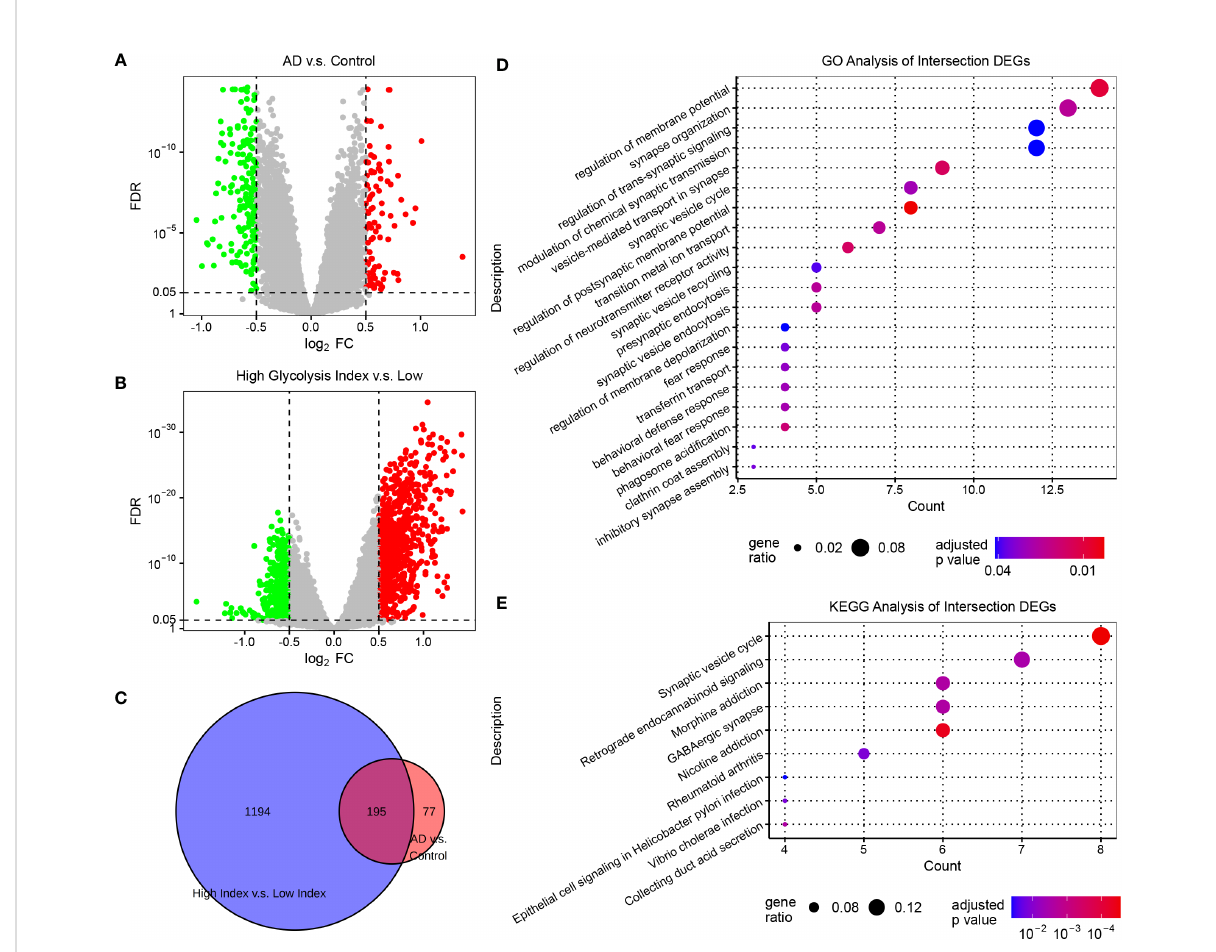
FIGURE 2 Screening glycolysis-related genes, and their relevant signaling pathways and functions in AD (A) Volcano plots of DEGs in AD vs. control samples. (B) Volcano plots of DEGs between AD samples with low and high glycolysis indices. The genes with FDR <0.05 and |log 2 FC|>0.5 are considered signi fi cant. (C) Venn diagram of the overlapping genes between the two differential expression analyses. (D) The GO enrichment analysis of intersection DEGs. (E) The KEGG enrichment analysis of intersection DEGs. DEG, differentially expressed genes; AD, Alzheimer ’ s disease; FDR, false discovery rate; GO, gene ontology; and KEGG, Kyoto Encyclopedia of Genes and